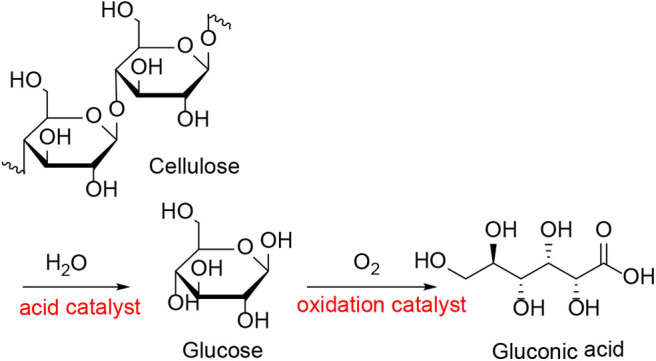
Catalytic conversion of cellulose to gluconic acid with Au/CsxH3xPW12O40.